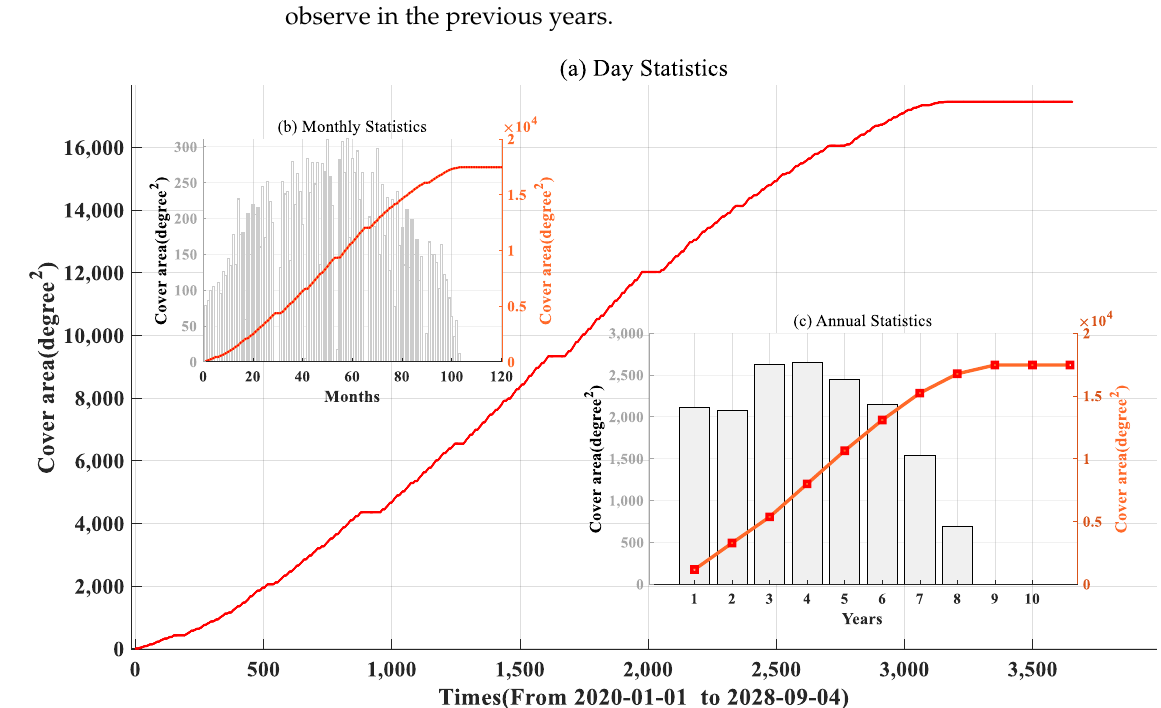
Figure 7. Statistical results of sky survey coverage efficiency. ( a ) The cumulative statistical results according to the daily coverage efficiency. ( b ) The cumulative coverage efficiency according to the monthly statistics and the results of each month. ( c ) The cumulative results of the coverage efficiency according to the annual statistics and the data of each year.